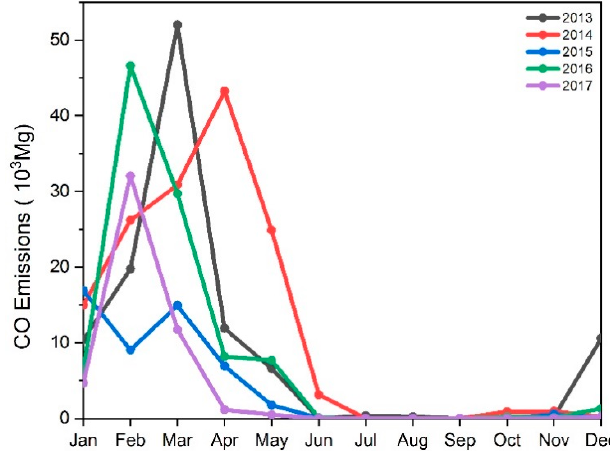
Figure 9. Monthly CO emissions of forest fires from 2013 to 2017 in southwest China.